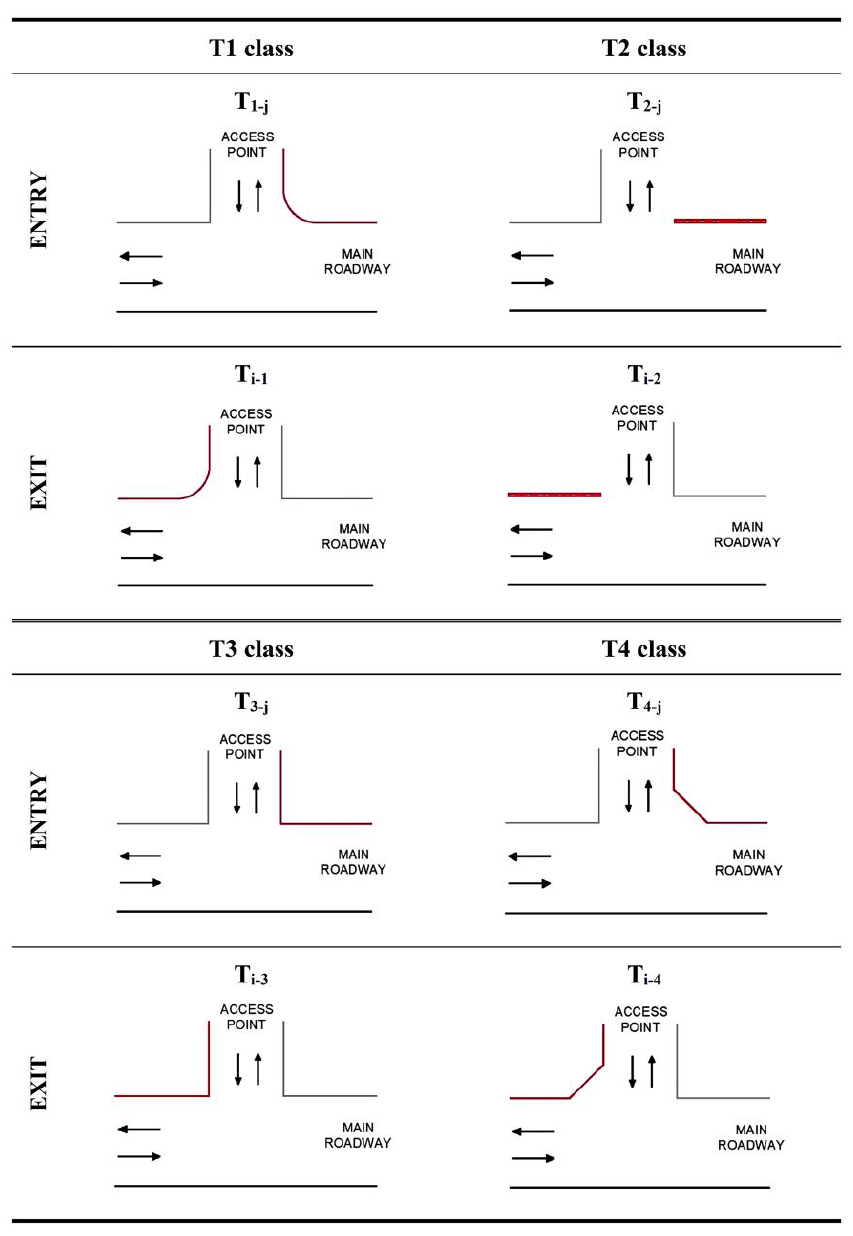
Figure 2. Types of connection transition geometries (top view). The grey line identifies the variable shape i (entry) or j (exit); (the characterization of each access point by the combination of the entry and exit transition shapes is reported in Figure 7).